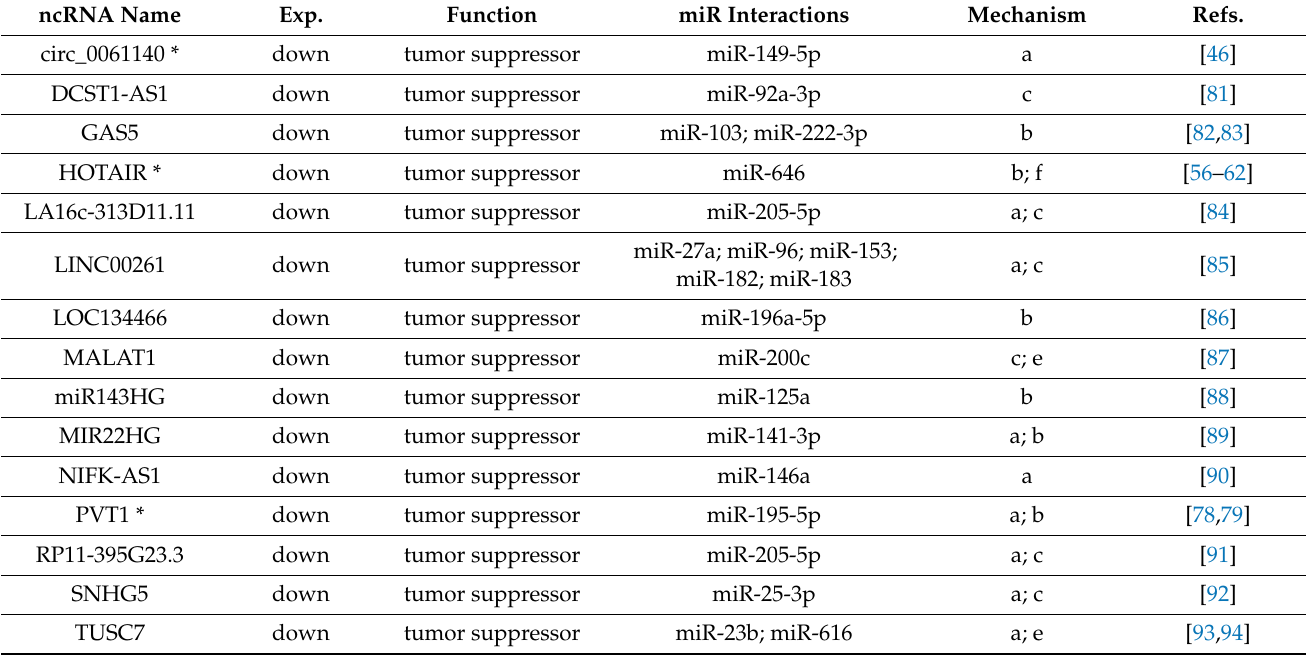
Table 4. A summary of ncRNAs that play a role as tumor suppressors in EC pathogenesis and for which a functional characterization is